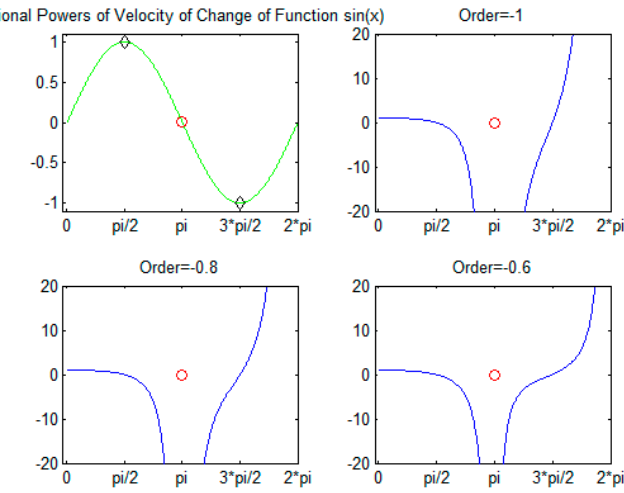
Figure 10. The rates of change for f ( x ) = sin( x ) for orders { − 1, − 0.8, − 0.6}.